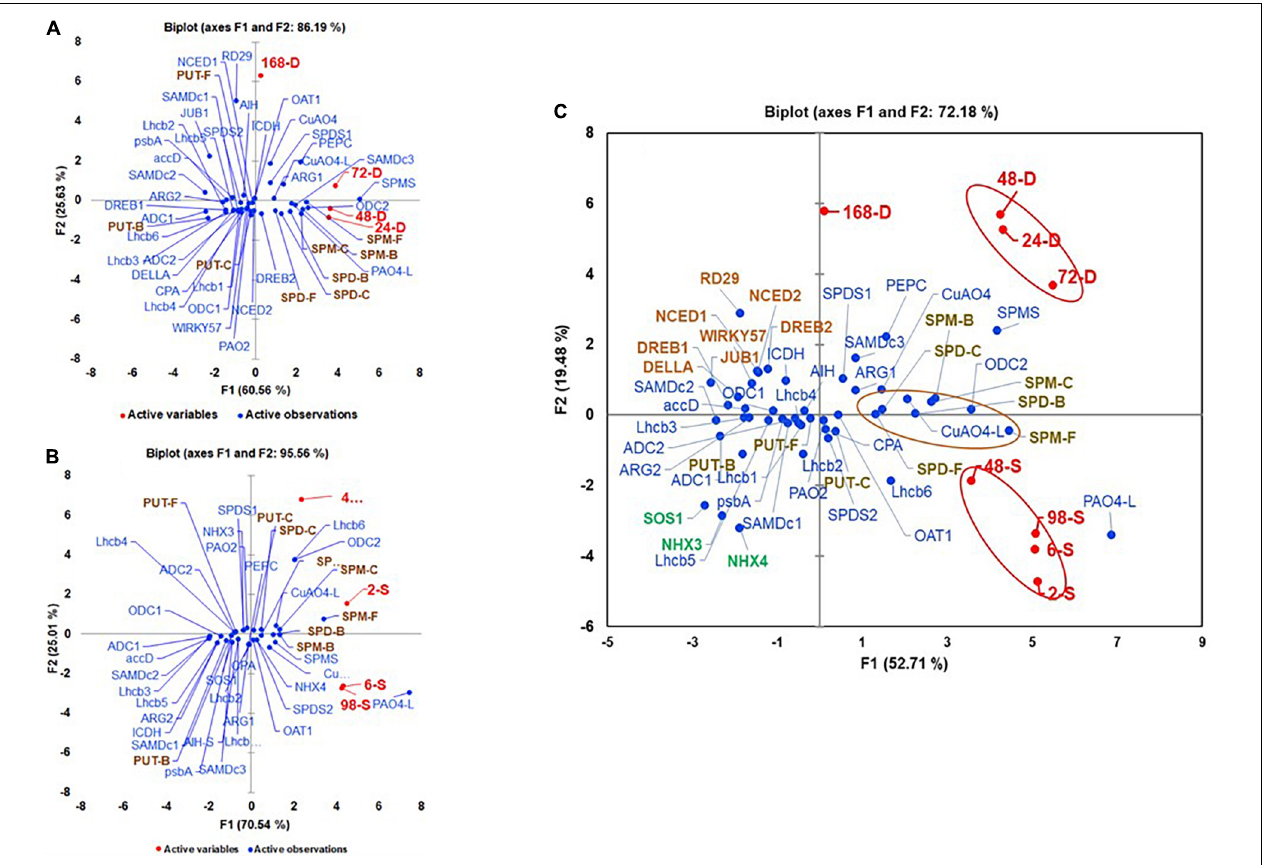
FIGURE 9 | Perchloric Acid analyses of active and variable parameters during (A) drought, (B) salt stress, and (C) their pooled data. The active parameters included leaves exposed to 24, 48, 72, and 168 h of water withholding (A) and 2, 6, 48, and 98 h of 200-mM NaCl treatment (B) and data from two stresses pooled for each parameter before analysis (C) . The variable parameters included levels of free (F), conjugated (C), and bound (B) PUT, SPD, and SPM (PUT-F, SPD-F, SPM-F, PUT-C, SPD-C, SPM-C, PUT-B, SPD-B, and SPM-B). Shown are the transcript levels of PAs biosynthesis and catabolizing enzymes-encoding genes, drought, and salt stress maker genes and photosynthetic machinery-related genes. Other details as stated in the material and method section. Gene abbreviations were the same as in Supplementary Tables S1, S2